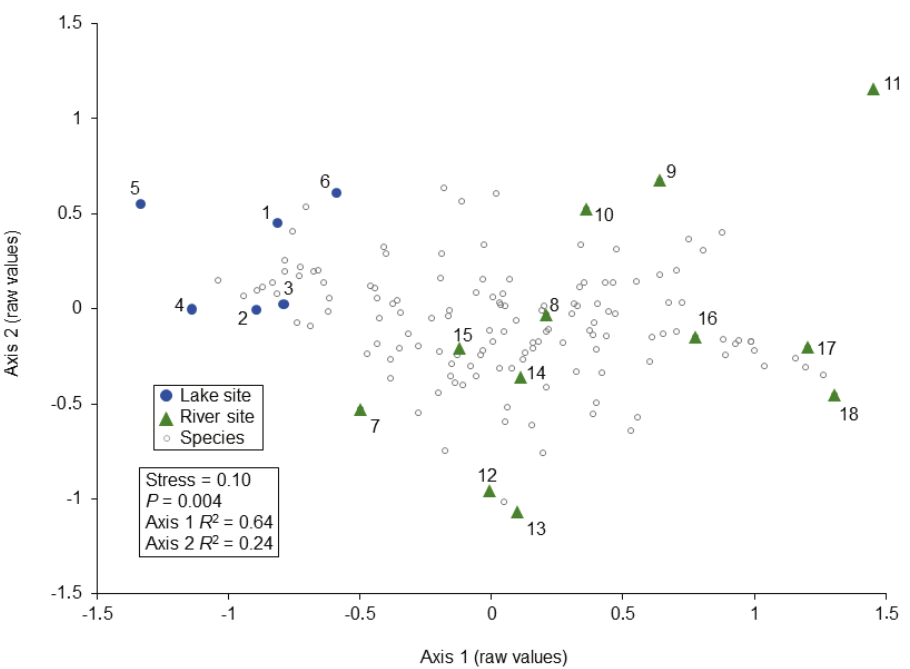
Figure 3. NMDS ordination of the 18 sampling sites based on caddisfly log per site, and reflecting the combined four samples for each site. P -values from a Monte Carlo test of non-ran- dom ordination structure. Site numbers correspond to Fig. 1 and Tables 1, 2. Species labels omitted for